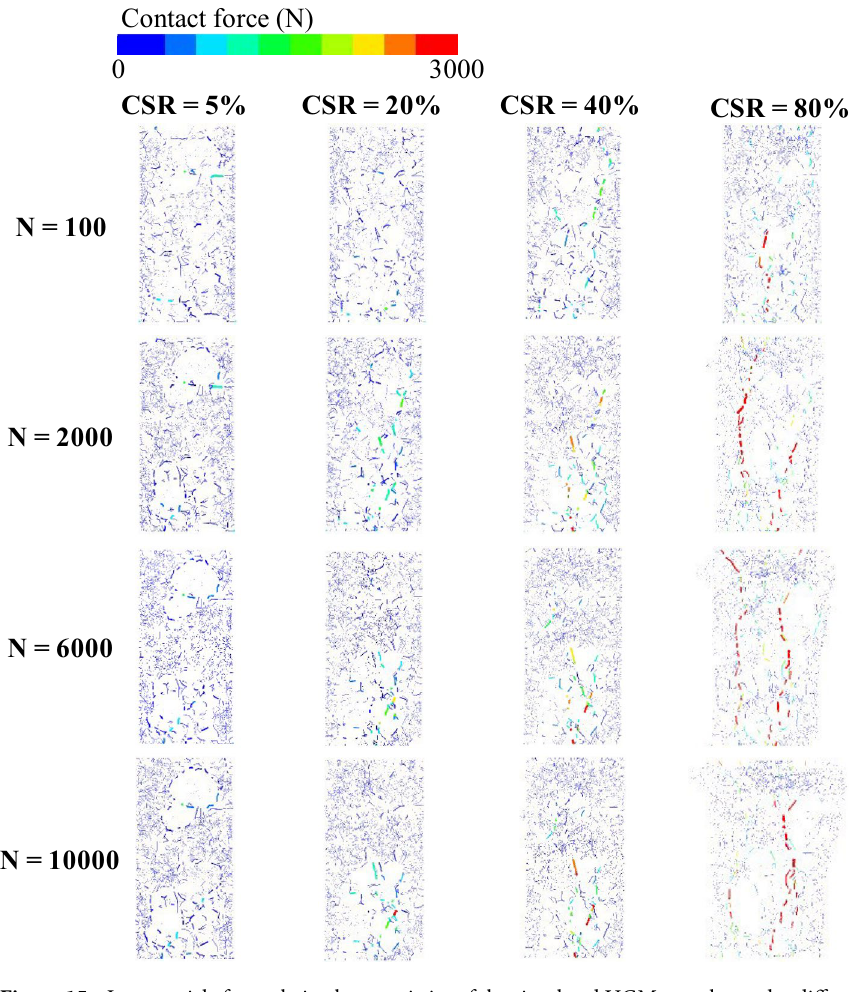
Figure 15. Interparticle force chain characteristics of the simulated UGM samples under different CSRs obtained by discrete element